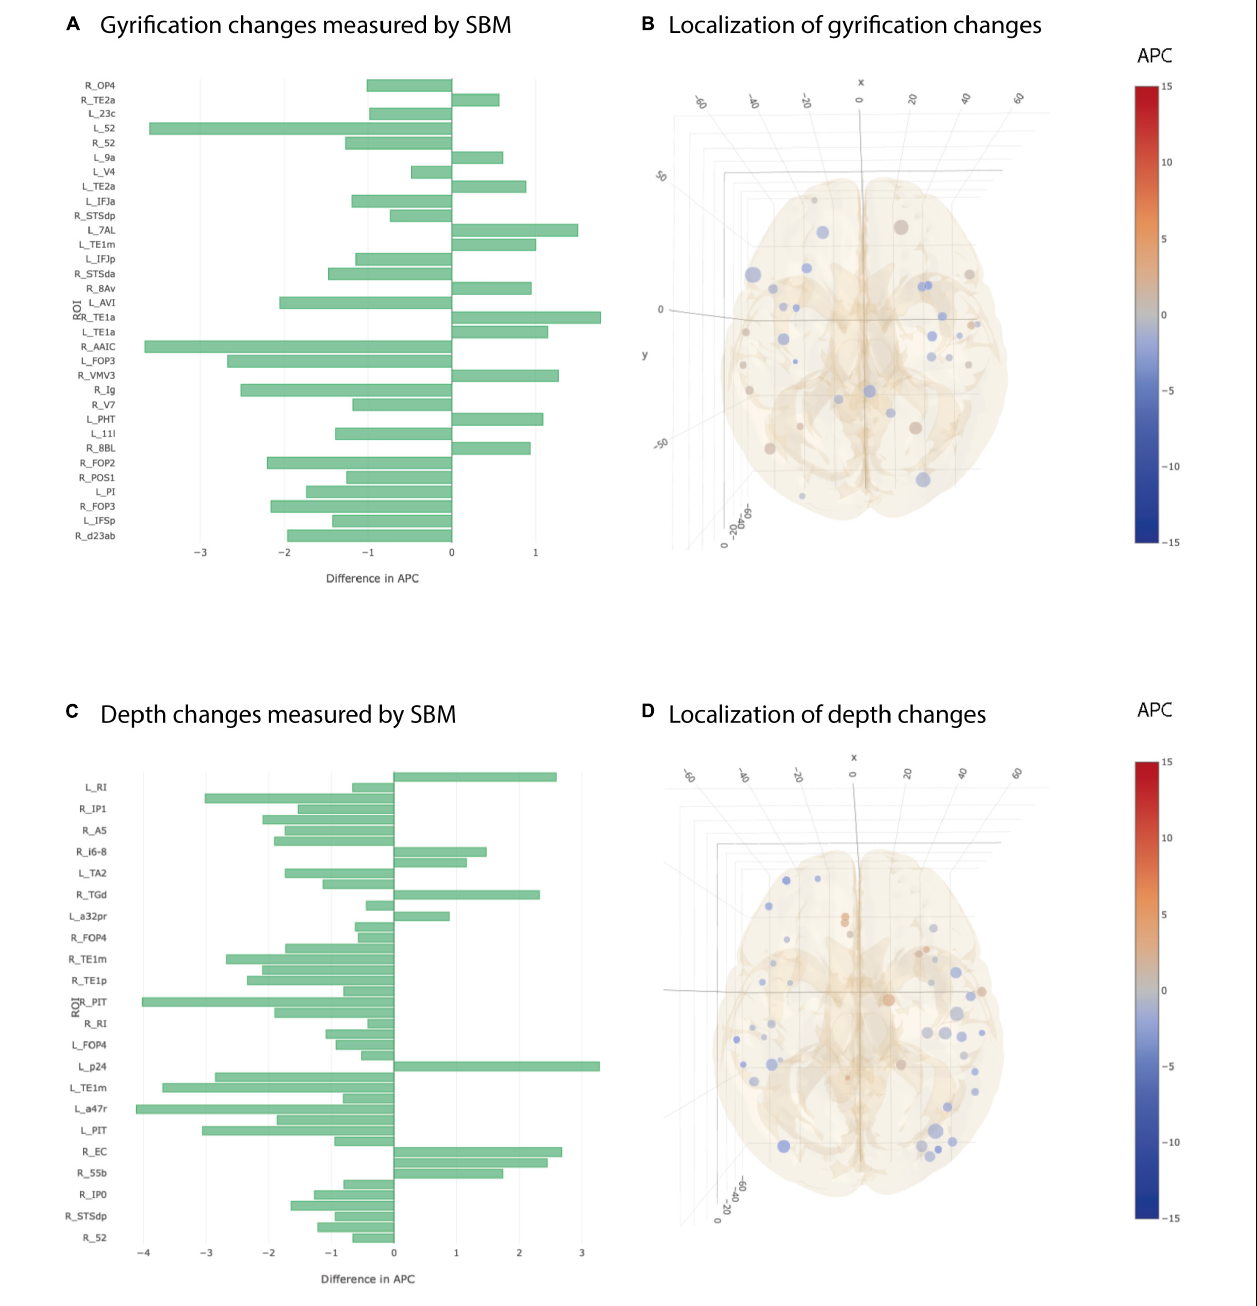
FIGURE 5 | Significant differences at individual testing level of annual percent changes in cortical gyrification and depth. (A) Horizontal bar plot of differences in group averaged cortical gyrification changes (longitudinal SBM) between AD and CN groups. Bars to the left indicate a relatively stronger decrease in APC values in AD group than in CN group. (B) 3D lattice graph of ROIs with significant differences in cortical gyrification changes corresponding to panel (A) . Each circle is located at the center of mass of the corresponding ROI in MNI152 coordinate space. Color code indicates group extend and sign of APC differences whereas the diameter indicates absolute effect size. Brain hull was derived from a T1-weighted MR image in MNI152 standard space. (C) Horizontal bar plot of differences in group averaged cortical depth changes measured by longitudinal SBM between AD and CN groups. Bars to the left indicate a relatively stronger decrease in APC values in AD group than in CN group. (D) 3D lattice graph of ROIs with significant differences in cortical depth changes (difference in APC) corresponding to panel (C) .